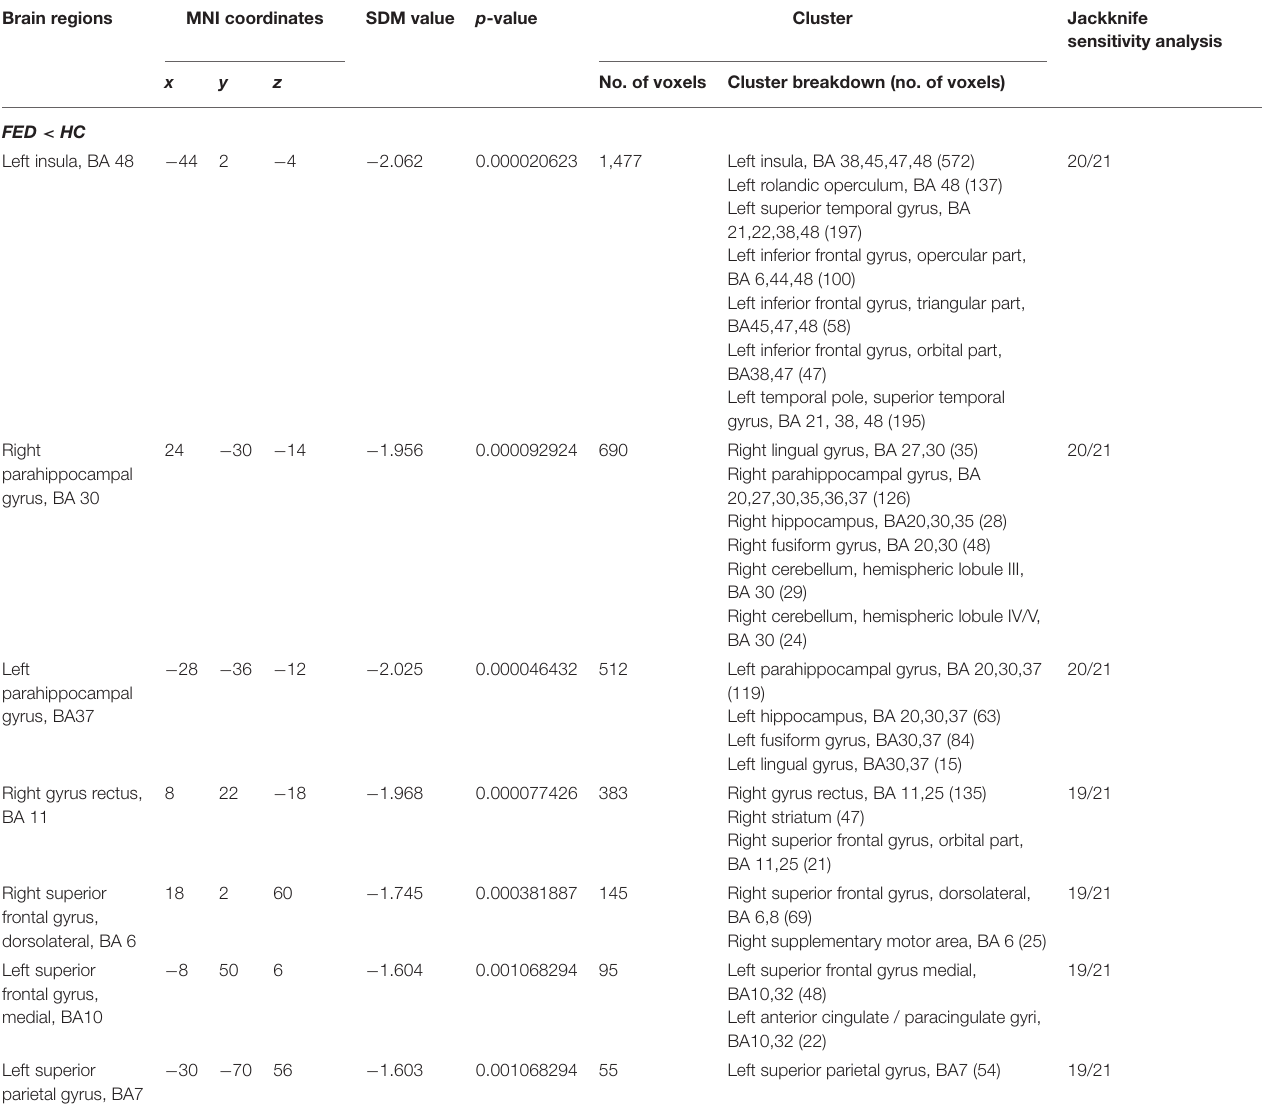
TABLE 2 | Regional differences in gray matter volume between FED patients and healthy controls in the pooled